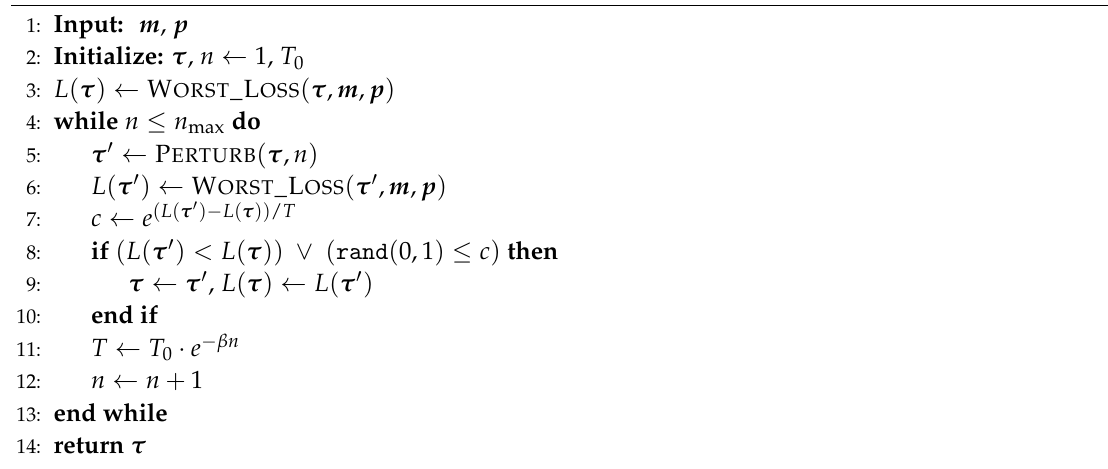
Algorithm 4 Algorithm for Design of the Application-Aware in a Time